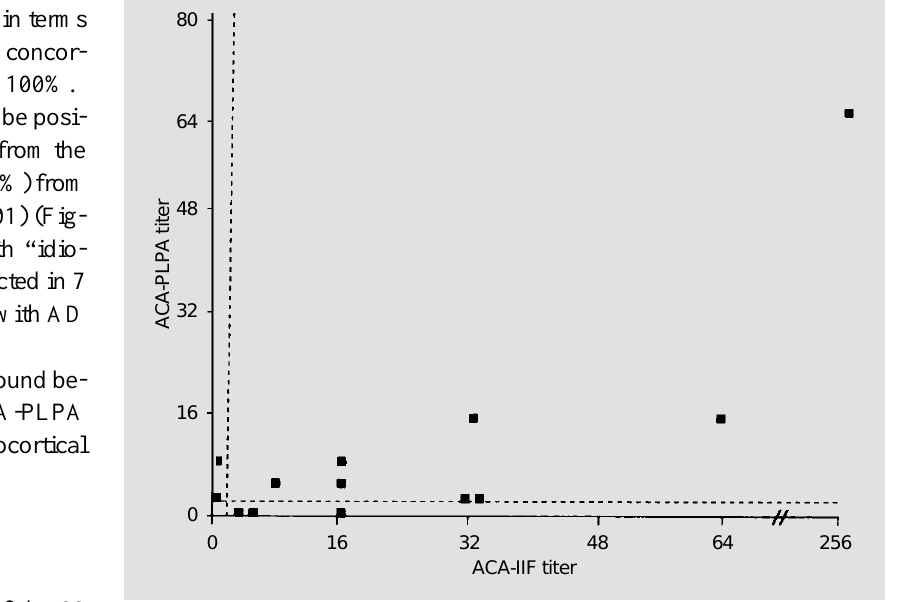
Figure 2 - Correlation between ACA-PLPA and ACA-IIF titers in ACA-positive patients (r 2 = 0.70; P<0.01). The dotted lines represent the upper normal level for each